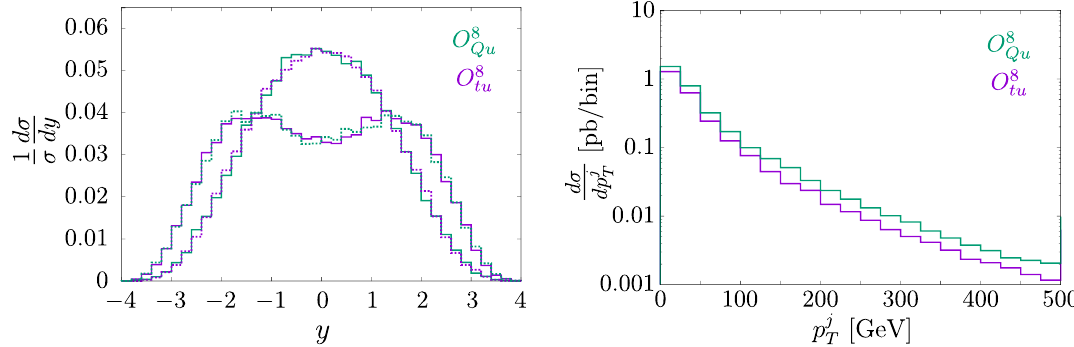
Figure 7 . Left: rapidity of top (plain curves) and anti-top (dashed curves) in pp ! t (cid:22) t for the SM-interference of the LR (green) and RR (purple) four-quark operators. Right: jet transverse momentum distribution in pp ! t (cid:22) tj for the SM-interference. cross sections and m distributions labelled ‘M’ in table 5 (red lines) and of the charge t (cid:22) t asymmetries A (black lines). The shaded blue region shows the combined (cid:12)t with both C datasets, which probes both vector and axial-vector currents with top quarks and breaks the respective blind direction in (cid:27) or A C